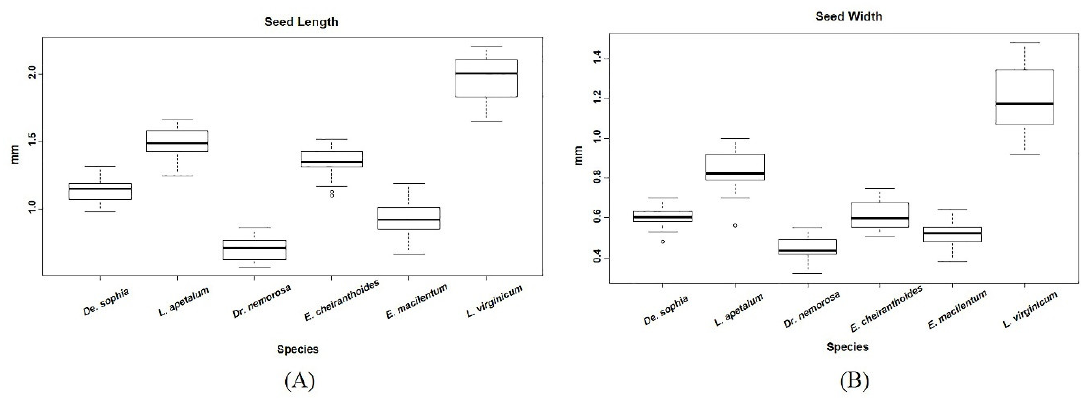
Figure 3. The size of Lepidii seu Descurainiae Semen and that of the seeds of related species: ( A ) seed length and ( B ) seed width. Box plots show the median, 25th, and 75th percentiles (box), 10th and 90th percentiles (whiskers), and outliers (open circle).